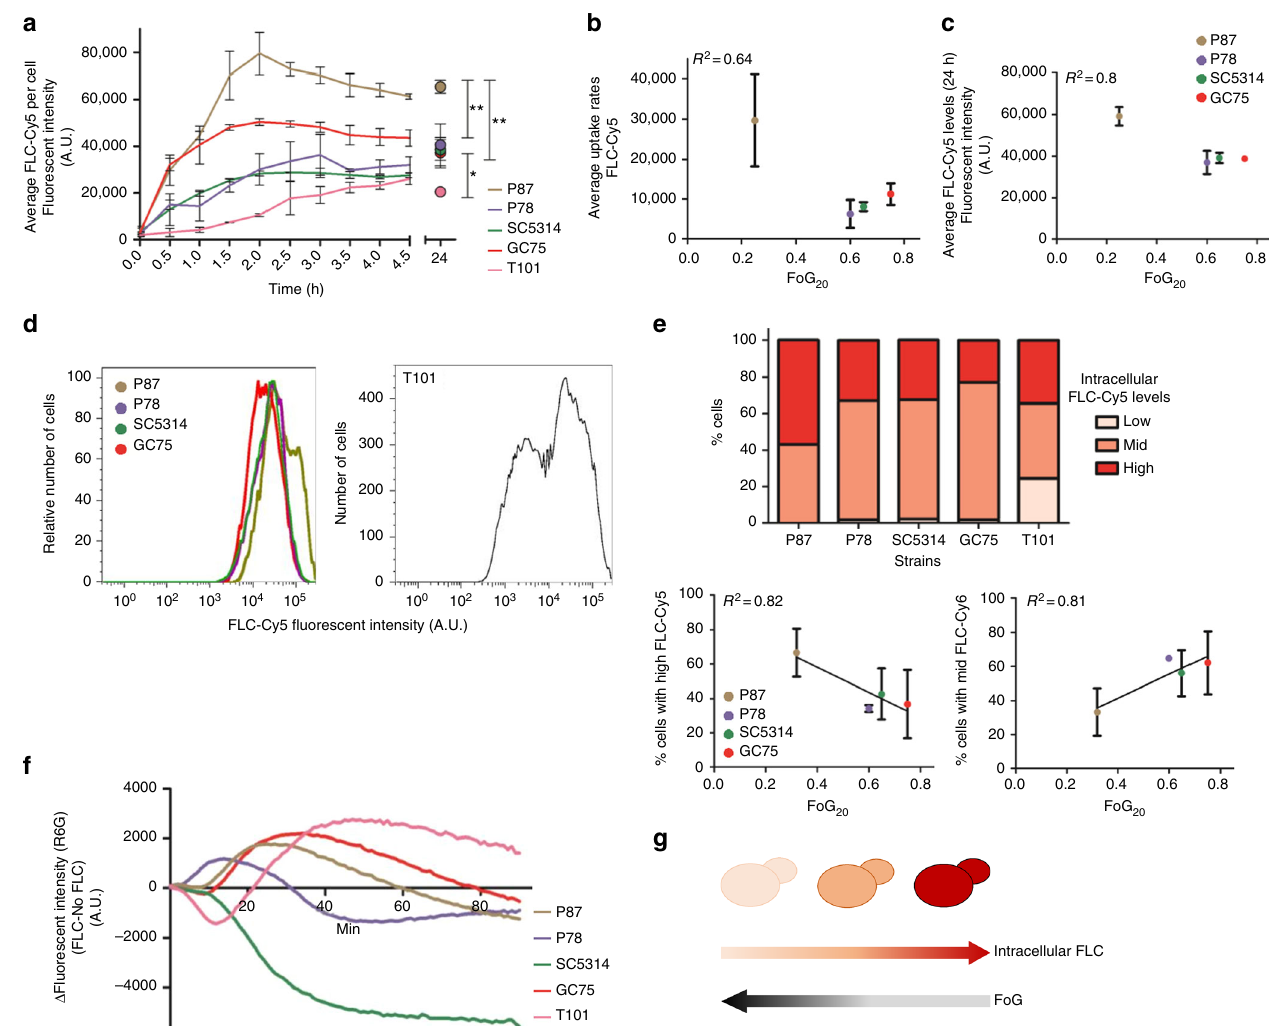
Fig. 3 Uptake, ef fl ux and steady-state intracellular concentrations of FLC-Cy5. a Average intracellular FLC-Cy5 uptake per cell. Uptake curves for 0 – 5 h and for steady-state FLC-Cy5 per cell at 24 h measured by fl ow cytometry. b , c Correlation between FoG 20 and uptake rate of FLC-Cy5 between 0.5 and 1.5 h ( b ) and intracellular FLC-Cy5 at 24 h ( c ). d Intracellular FLC-Cy5 fl uorescent intensity at 24 h for four strains with similar MIC and diverse FoG levels (left) and for the resistant strain T101 (right) normalized for number of cells ( n = 15863 for P87, 15075 of P78, 22406 for SC5314, 18186 for GC75). e The proportion of cells (%) with FLC-Cy5 levels at 24 h was divided into thirds: Low (391 – 422 A.U.), Mid (3912 – 34,643 A.U.), and High (3.5 × 10 4 – 3.14 × 10 5 A. U.) (upper panel). Proportion of cells (%) with high (lower left panel) or mid (lower right panel) intracellular FLC-Cy5 concentration at 24 h vs. FoG 20 levels of the strains. f Ef fl ux of Rhodamine 6G (R6G) normalized by culture density (OD 600 ). Ef fl ux curves represent data from one (of two) experiment and the curves show fl uorescence intensity recorded over 90 min and calculated as follows: Δ [FLC(with glucose − without glucose) − no drug(with glucose − without glucose)]. g Cartoon illustrates the steady-state drug levels in cells with high to low FoG levels. For all panels, n ≥ 2; ** P < 0.01; * P < 0.05, error bars denote standard